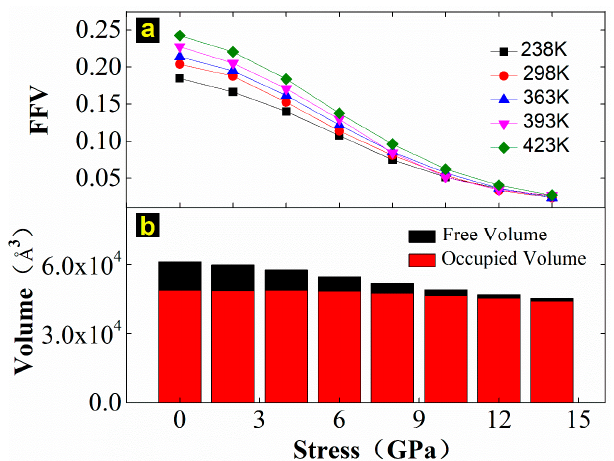
Figure 12. Influence of temperature and strain on the free volume of EPDM: ( a ) shows the variation curve of free volume with different compression stresses at different temperatures, ( b ) is the variation trend of the occupied and free volumes with varying stresses of compression at 298 K.